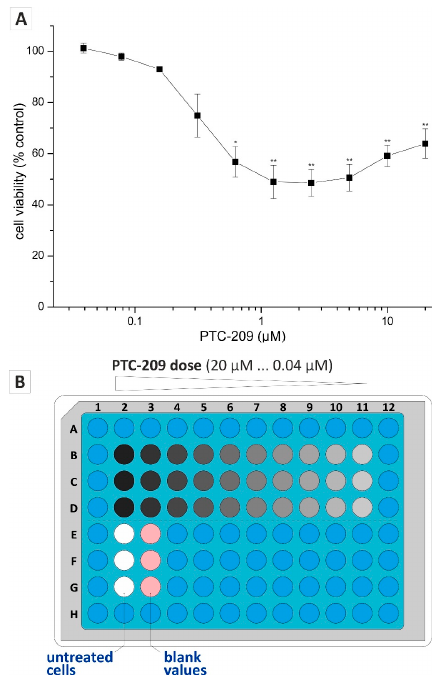
Figure 3. Setup for dilution series experiments for the clonogenic assay in the 96-well format. ( A ) Concentration-dependent effect of PTC-209 on cell viability of HuCCT-1 cells after 72 h (mean of n ≥ 3 experiments); ( B ) Blue-colored and light blue-colored wells and plate areas, respectively, indicate